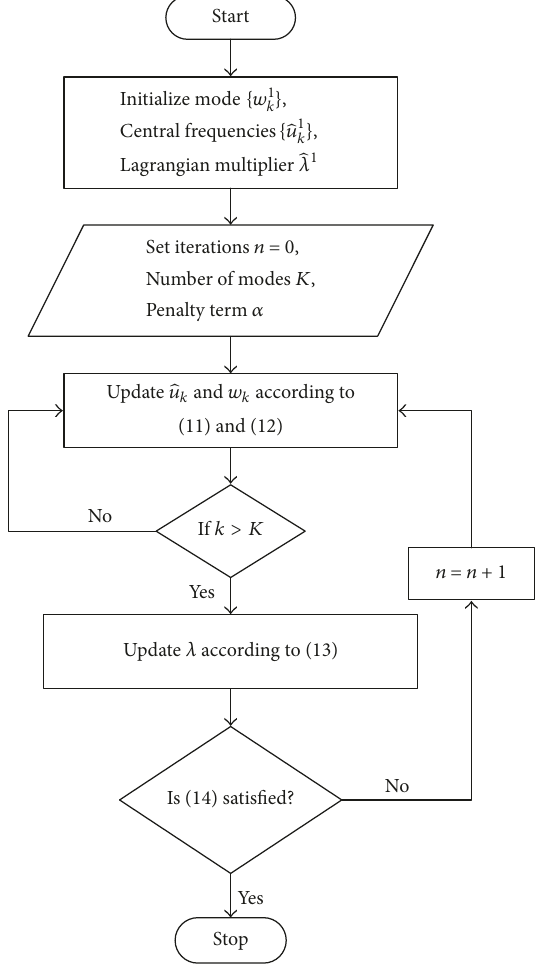
Figure 1: Flowchart of